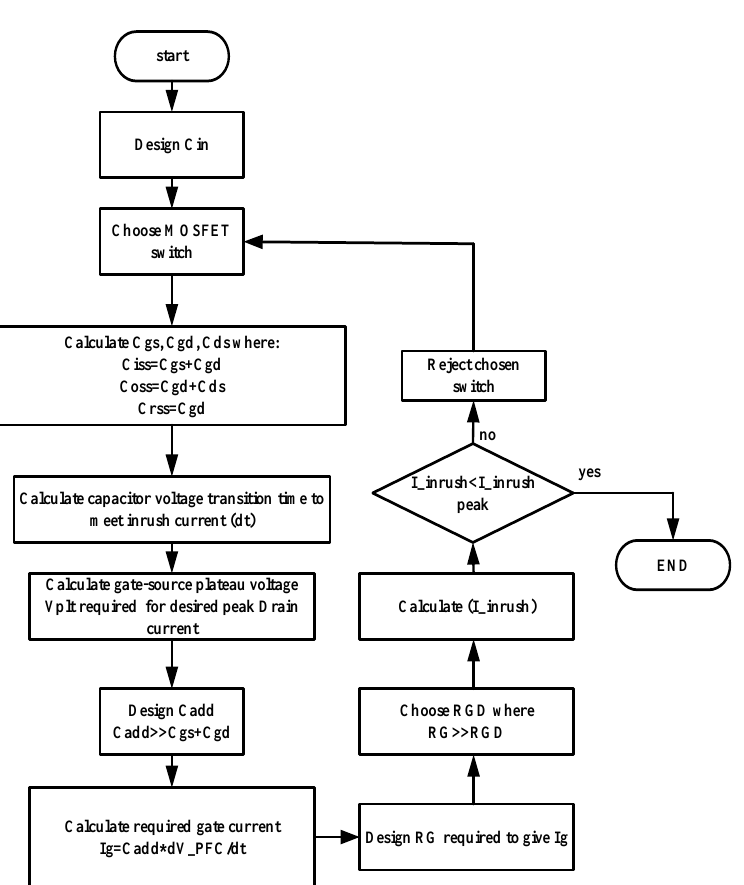
Figure 7. Flow chart of design process of the proposed inrush current control circuit. Table 1. Design Results for Active Inrush Current Control